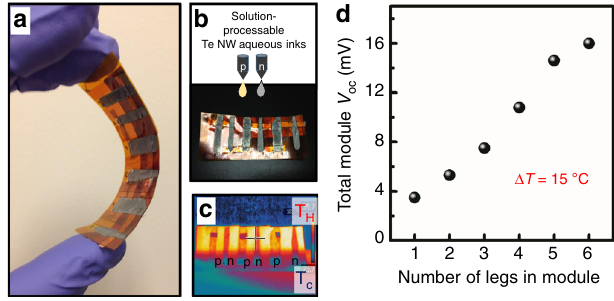
Fig. 7 Thermoelectric generator demonstrations for in-plane devices. a A fl exible module prepared from solution-processable Te NW inks in an unconventional thin- fi lm leg-geometry. b Module n - and p -type legs drop- cast onto Kapton substrate to make the array shown in a. c Infrared image depicting a temperature gradient of 15 ° C established across the thin- fi lm module. d Total module open-circuit voltage ( V OC ) generated as a result of the Seebeck effect as a function of the number of n - and p -type legs connected in series in the module depicted in a – c . Additive nature of the V fi rms the proper working of OC con